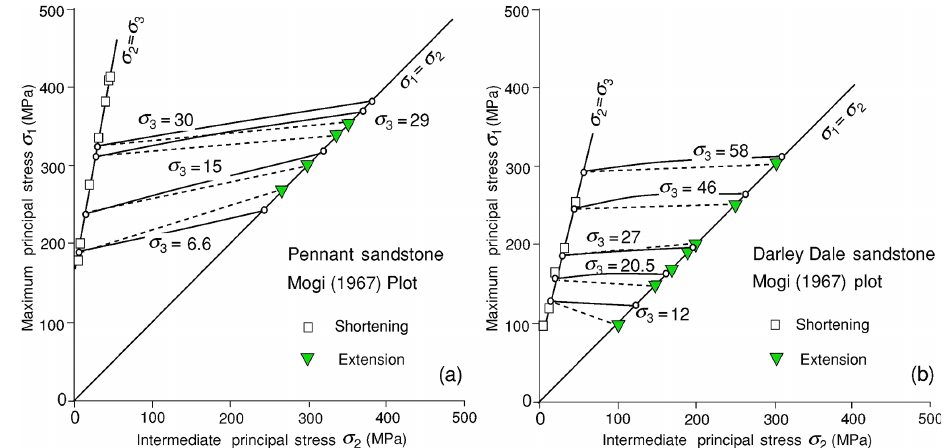
Figure 12. Test of how well the Mogi (1967) polyaxial failure criterion predicts the results of extension tests from the Mohr–Coulomb description of the shortening tests for Pennant and Darley Dale sandstones. Dashed lines link experimental results for specific extension tests (inverted triangles) to the expected σ 1 values in shortening for the same value of σ 3 . For each such value of σ 3 (indicated) the expected failure point in extension is calculated (small circles on the σ 1 = σ 2 line), plus the shape of the failure criterion for intermediate values of σ 2 . There is a moderately good correspondence.